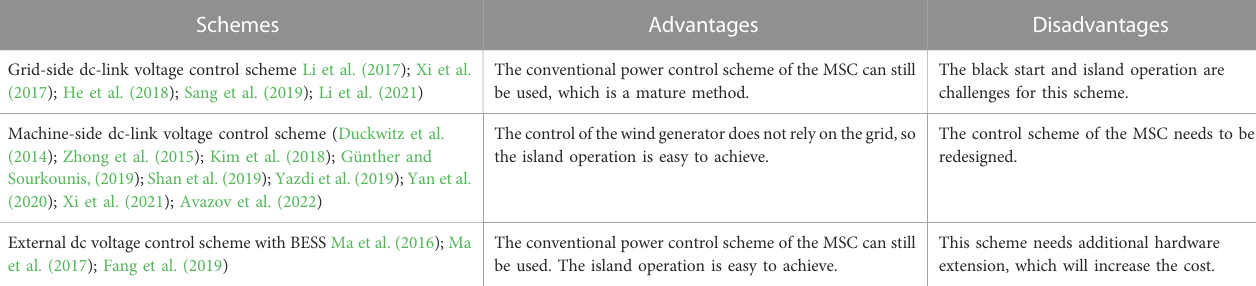
TABLE 1 Comparison of three dc-link voltage control schemes of type-4 wind generators. Schemes Advantages